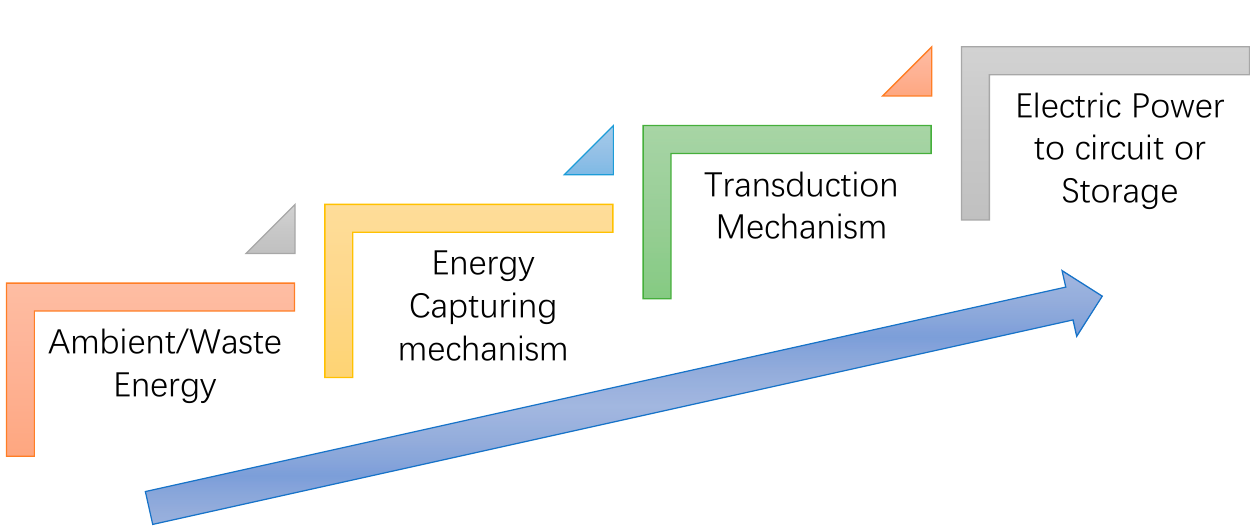
Figure 1. Schematic representation of an energy harvesting device.